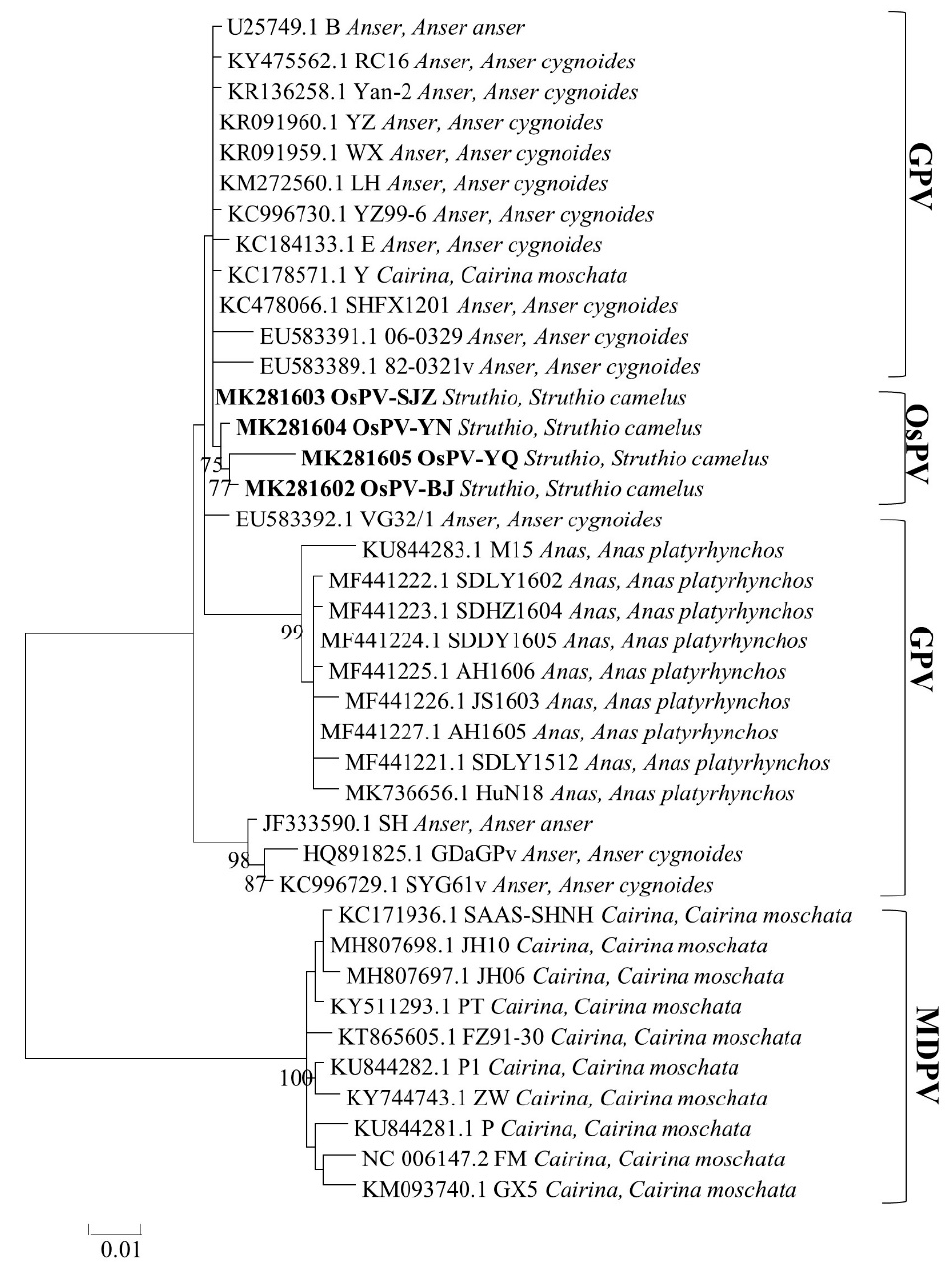
Figure 2. Phylogenetic trees based on complete genomic sequence ( a ), capsid proteins ( b ), replication proteins ( c ) were constructed by using the maximum likelihood method with a Poisson model, based on 1000 bootstrap duplicates. Bootstrap values > 70% were considered to be significant.